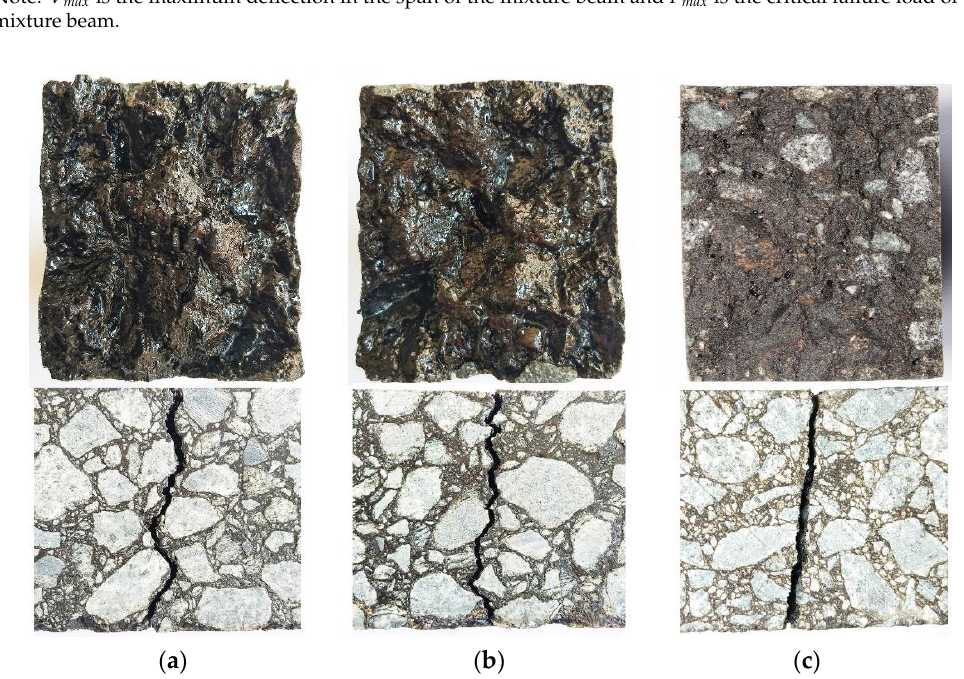
Table 10. Three-point bending test results for EACs with the three types of aggregates.